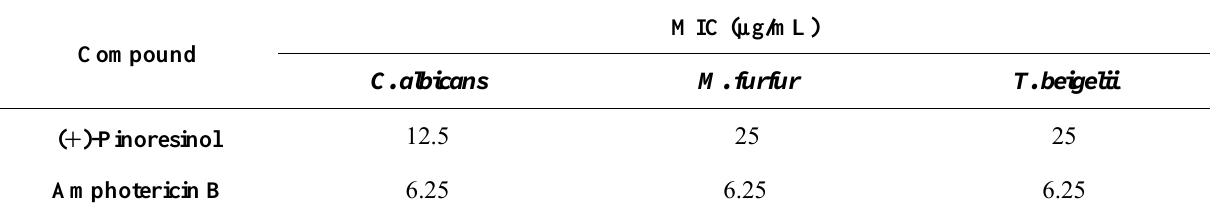
Table 1. Antifungal activity of ( + )-pinoresinol.